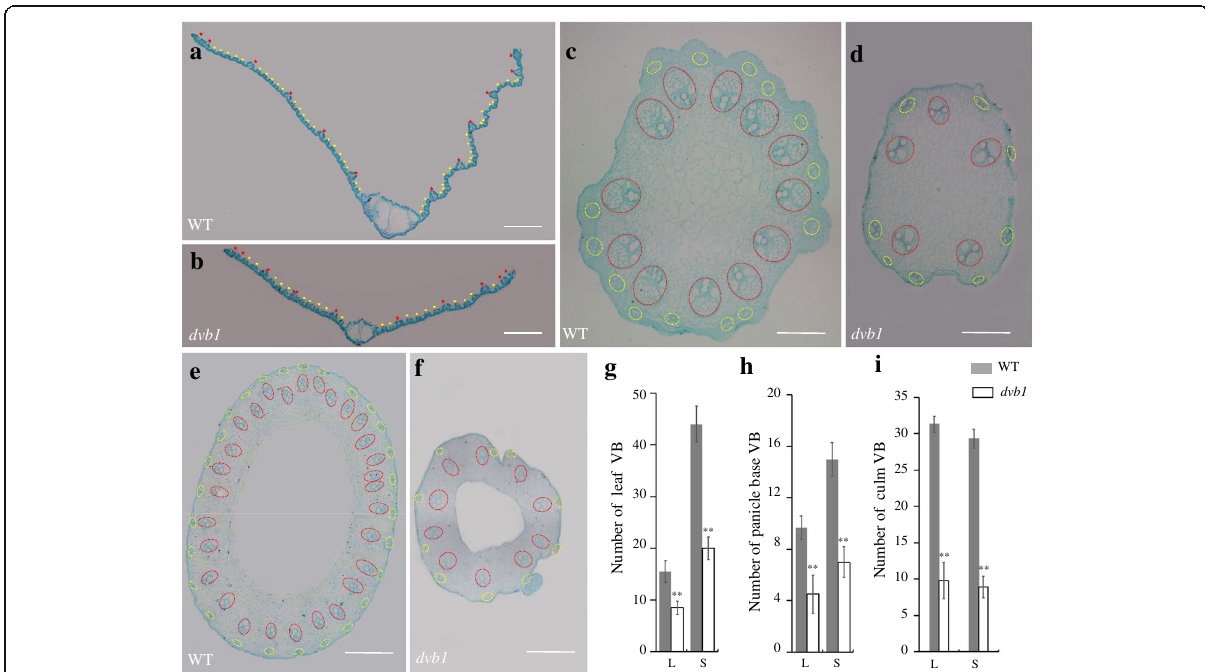
Fig. 2 Vascular bundles in the dvb1 mutant and wild type. a – f Transverse sections of the leaf ( a ), panicle base ( c ), and culm ( e ) of the wild type, and the leaf ( b ), panicle base ( d ), and culm ( f ) of the dvb1 mutant. Red labels indicate larger vascular bundles and yellow labels indicate smaller vascular bundles. g – i Number of vascular bundles in the leaf ( g ), panicle base ( h ), and culm ( i ) of the wild type and the dvb1 mutant. Values represent means ± SD from 10 biological samples. Asterisks indicate the significance of differences between the wild type and dvb1 as determined by Student ’ s t -test (*, 0.01 ≤ P <0.05; **, P <0.01). VB, vascular bundles; L, larger vascular bundles; S, smaller vascular bundles. Scale bars: 0.1mm ( a – f